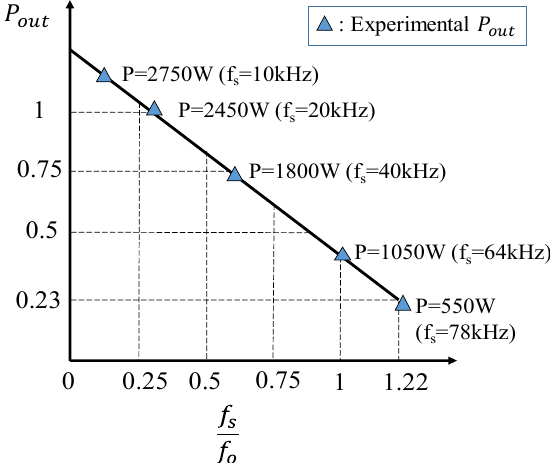
Figure 12. Characteristics of output power 𝑃 (cid:3042)(cid:3048)(cid:3047) versus switching frequency ratio 𝑓 (cid:3046) /𝑓 (cid:3042) .